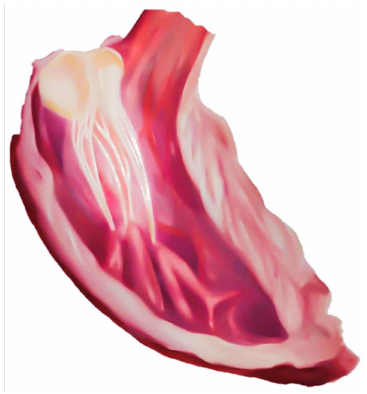
Figure 10. Graphic representation of tricuspid valve